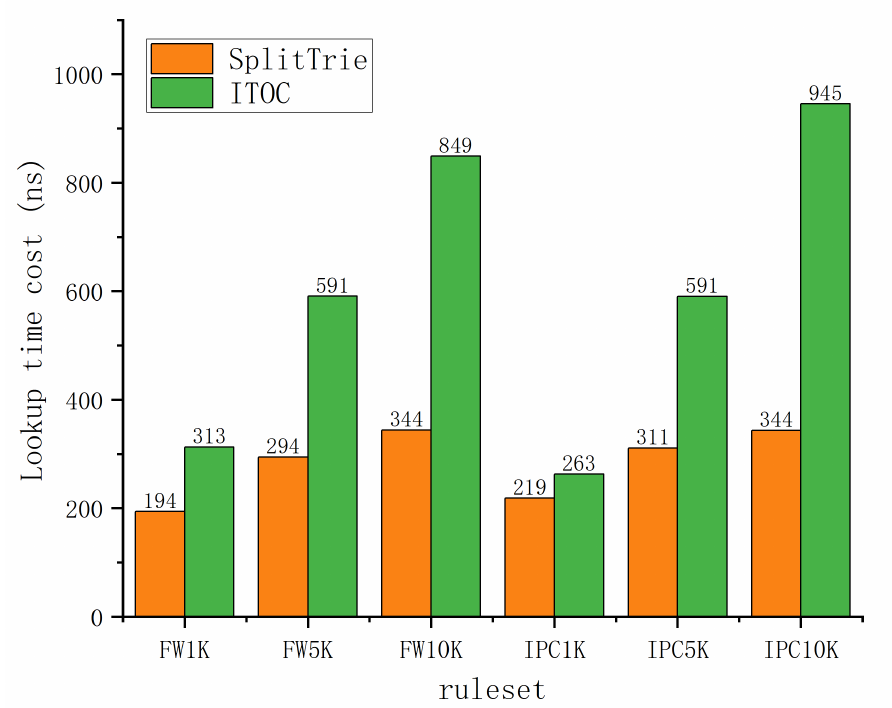
Figure 8. The lookup time cost comparison between SplitTrie and